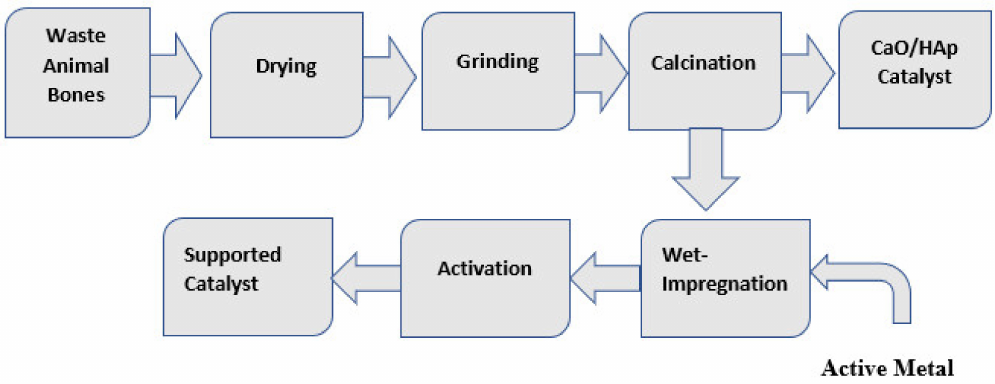
Figure 1. The generic practice for the manufacturing of CaO/HAp-derived catalyst/Supported catalyst.